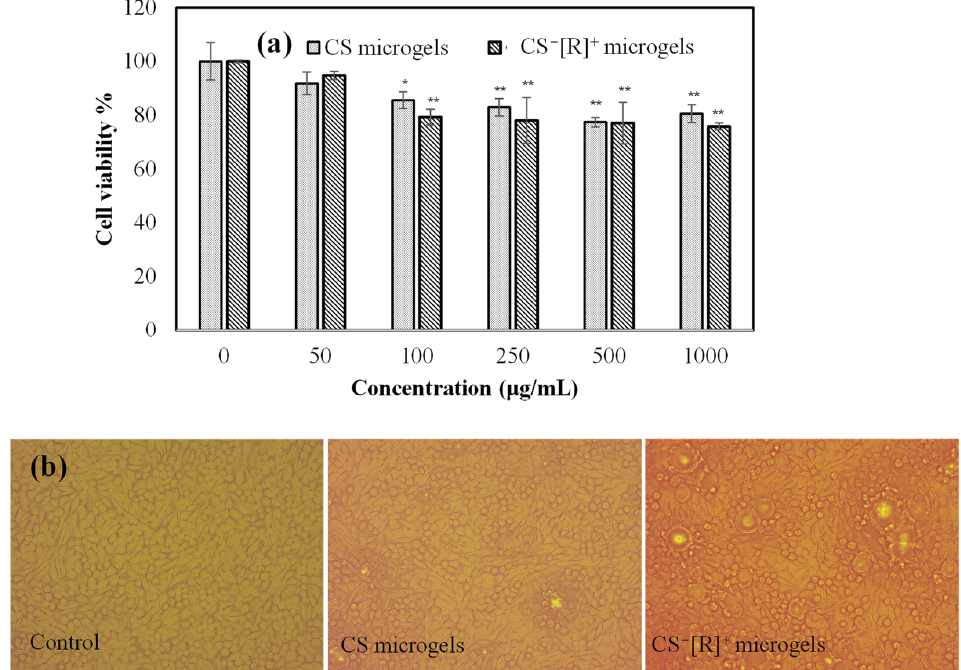
Figure 4. ( a ) Cell viability of L929 fibroblasts in the presence of different concentrations of CS and CS - [R] + microgels and ( b ) optic microscope images of L929 fibroblast cells for control groups and 1000 μ g/mL concentrations of CS microgels and CS - [R] + microgels [* p < 0.005, ** p < 0.01 vs. control].